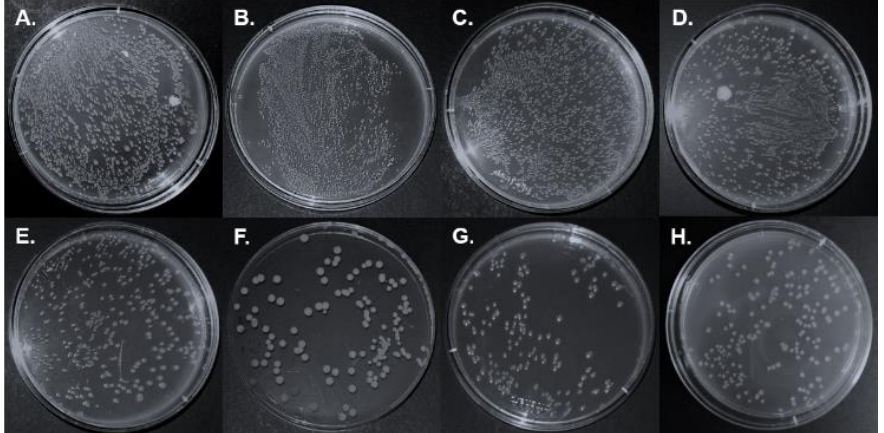
Figure 4. Different films co-cultured with E. coli after 48h and observation of effects on the growth inhibition of E. coli . ( A ) E. coli ; ( B ) collagen film; ( C ) collagen with none-modified APL film; ( D ) collagen with C. echinulate FR3-modified APL film; ( E ) collagen with G. lucidum EN2-modified APL film; ( F ) collagen with P. ostreatus BP3-modified APL film; ( G ) collagen with S. commune DS1-modified APL film; ( H ) collagen with Xylariaceae sp. XY-modified APL film.